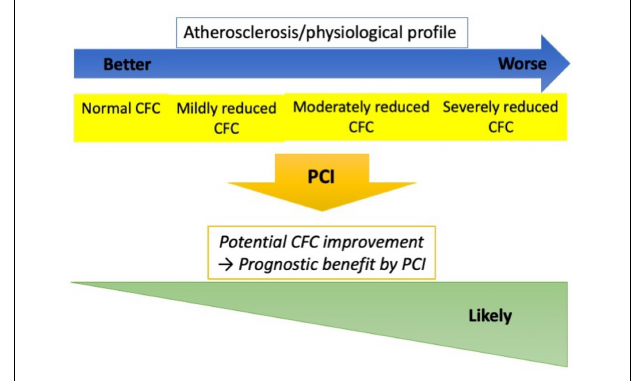
FIGURE 6 | Study summary. Worse CFC status was associated with higher atherosclerotic risk and worse coronary physiological profile. However, the clinical courses were similar across the pre-PCI CFC if treated by elective PCI, while the changes in CFC following PCI were robustly associated with the risk of TVF. Furthermore, CFC changes are largely determined by the pre-PCI status. These observations implicate that lesions with reduced CFC could potentially attain greater CFC improvement by PCI, and consequently the lowered risk of vessel-oriented adverse events. CFC could thus serve as guidance for elective PCI indication, which needs to be evaluated in studies comparing PCI versus medical therapy in reduced CFC